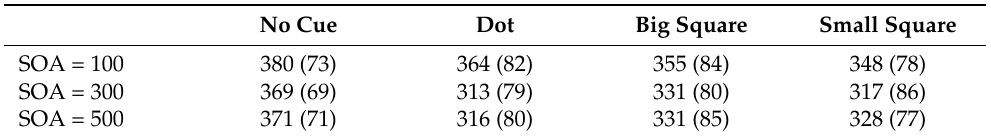
Table 2. Mean reaction times for Experiment 3 in response to targets preceded by no cue or a dot, a big square, or a small square as cues. Results are reported for SOAs of 100, 300, and 500 ms. Values in brackets indicate standard deviations.